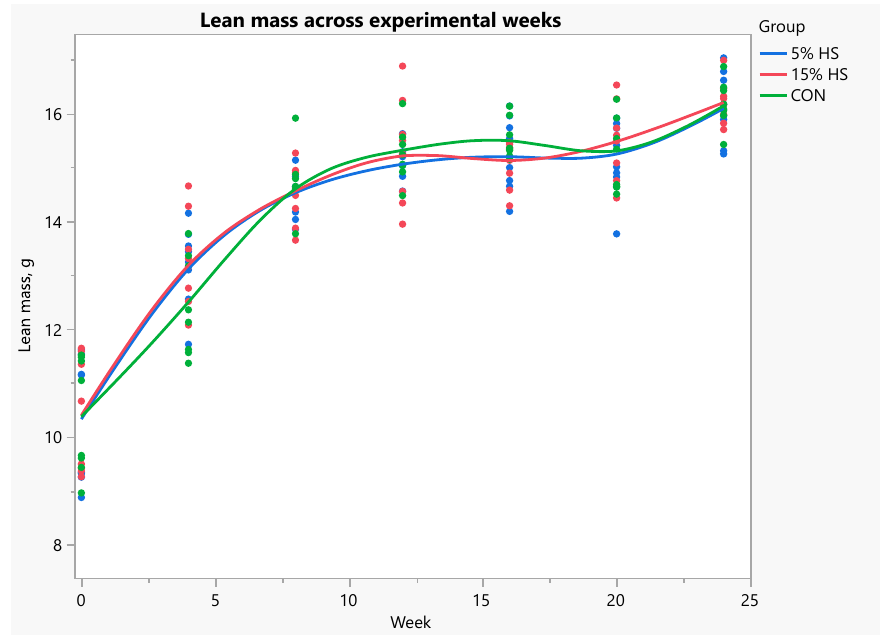
Figure 9. Lean mass (g) across experimental weeks. Measurements obtained by dual-energy X-ray absorptiometry in live mice. N = 8 per group. Each dot represents an individual mouse; colors represent the experimental diet group. Mixed models with repeated measures showed no significant differences among group ( p = 0.92). Effect of week, p < 0.0001.